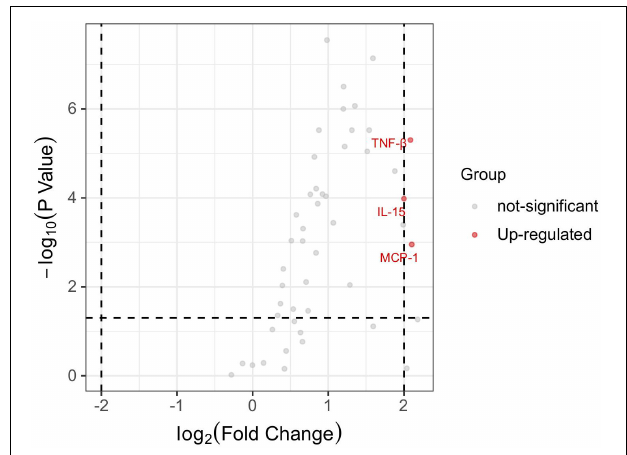
FIGURE 2 | The volcano plot of differential expressed serum cytokines between low risk and intermediate-high risk patients. P < 0.05 and |log 2 fold change| > 2 were used to identify the differential expressed serum cytokines. MCP-1, IL-15, and TNF- β were significantly up-regulated in intermediate-high risk patients. IL-15, interleukin 15; MCP-1, monocyte chemoattractant protein-1; TNF- β , tumor necrosis factors- β